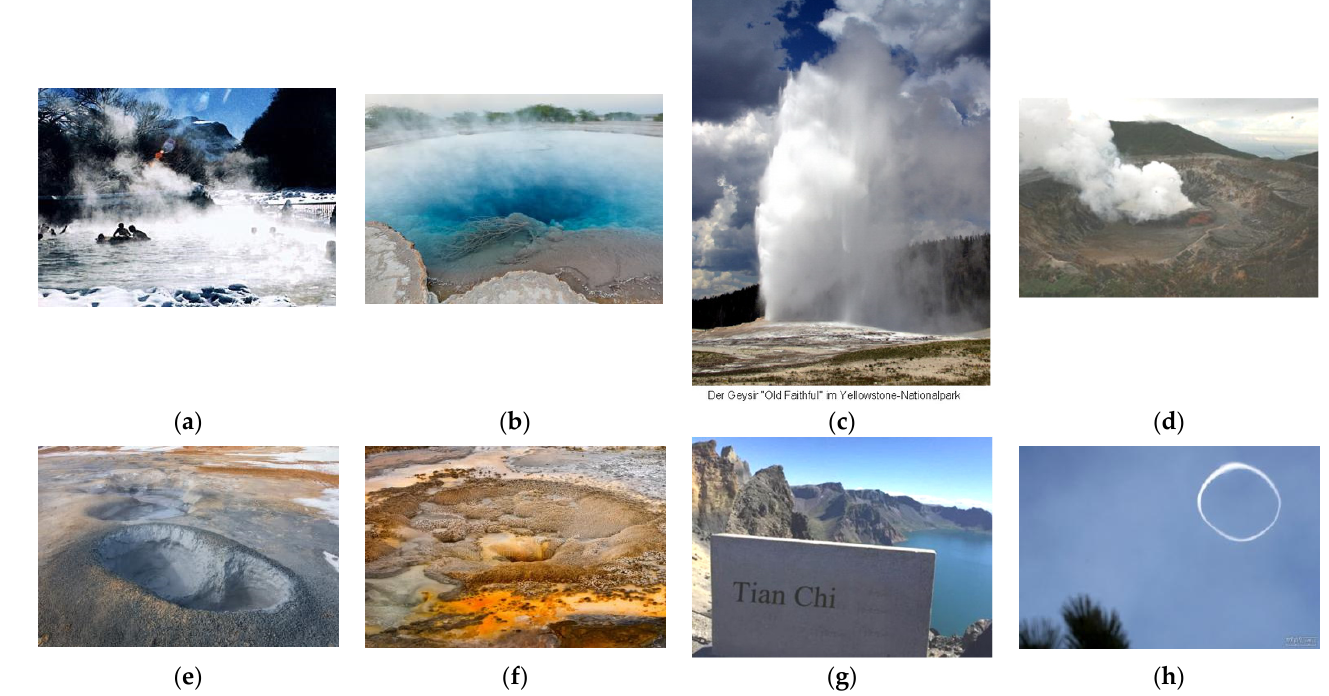
Figure 2. Example images of the eight types of geothermal surface manifestations (GSMs): ( a ) warm spring, ( b ) hot spring, ( c ) geyser, ( d ) fumarole, ( e ) mud pot, ( f ) hydrothermal alteration, ( g ) crater lake, and ( h ) none of GSM.